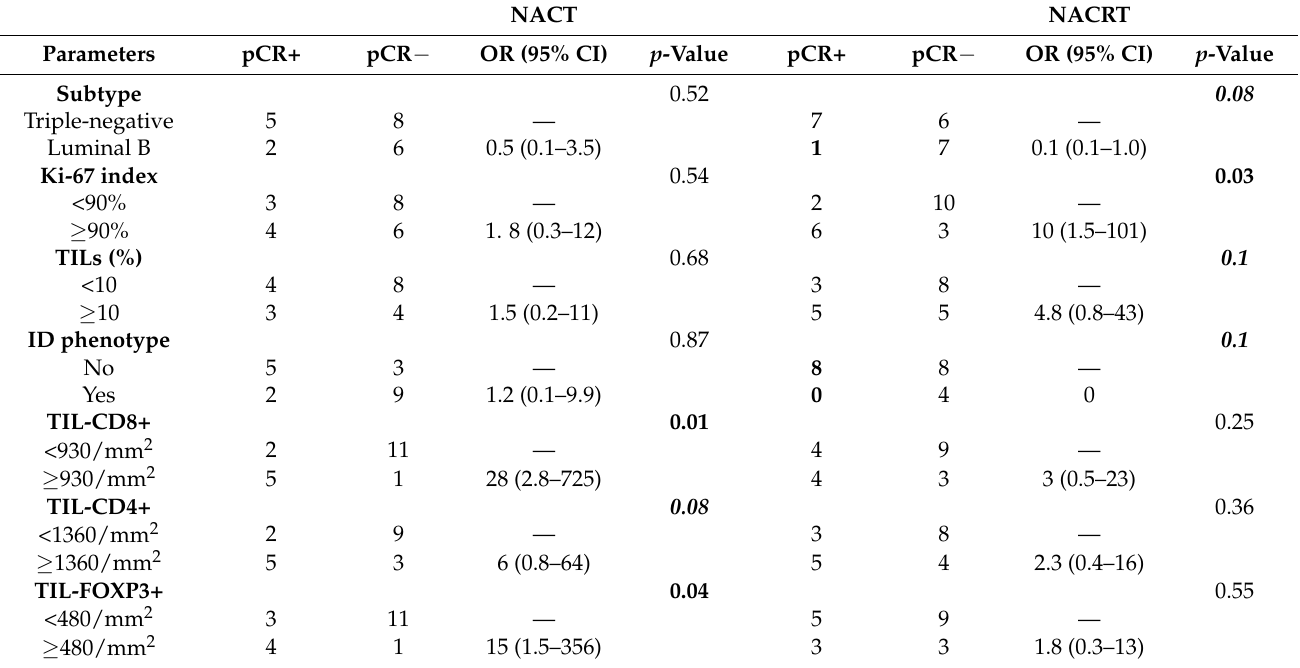
Table 4. Associations between tissular parameters and response to neoadjuvant